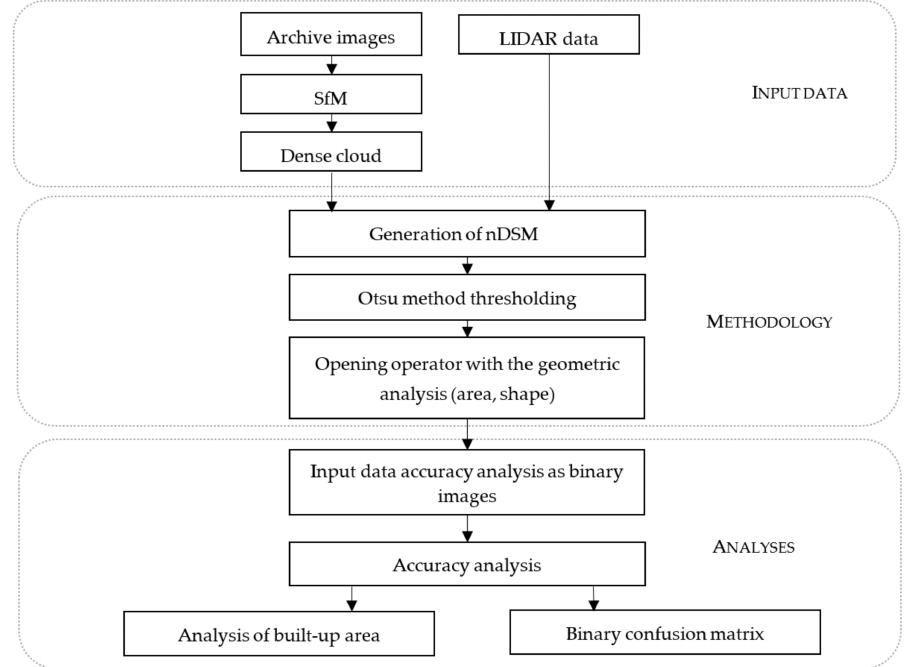
Figure 4. Algorithmic workflow. The schematic representation of the algorithm is depicted through the flowchart, showing the three stages through which the input data are analysed to return the information about buildings.